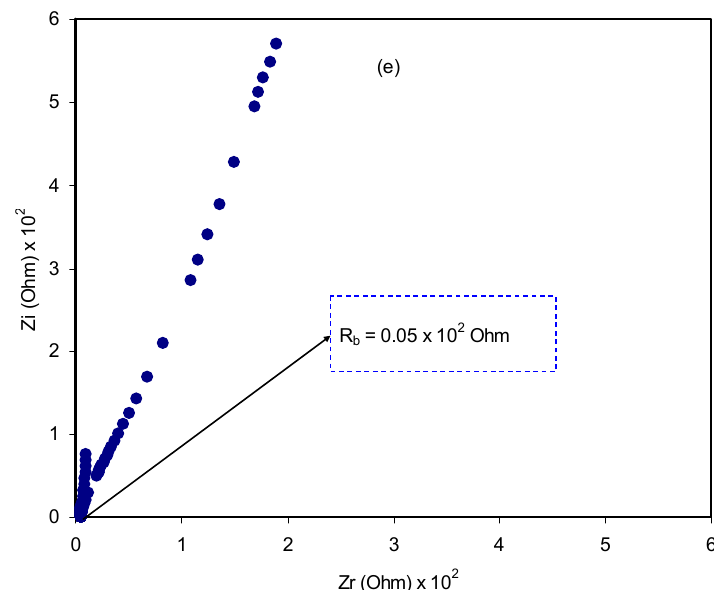
Figure 4. Impedance plots for ( a ) pure CS:Dex film, ( b ) CSDX1, ( c ) CSDX2, ( d ) CSDX3, and ( e ) CSDX4 blend electrolyte films. Table 1. Conductivity for pure CS:Dex and blend electrolyte films at room temperature. Sample Designation